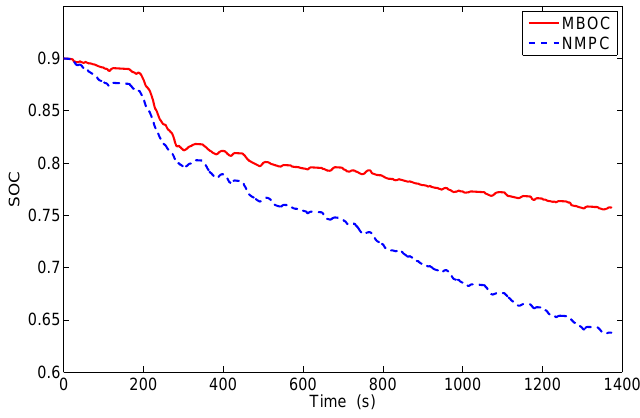
Figure 12. SOC for MBOC and NMPC strategies in ζ = 0 . 82